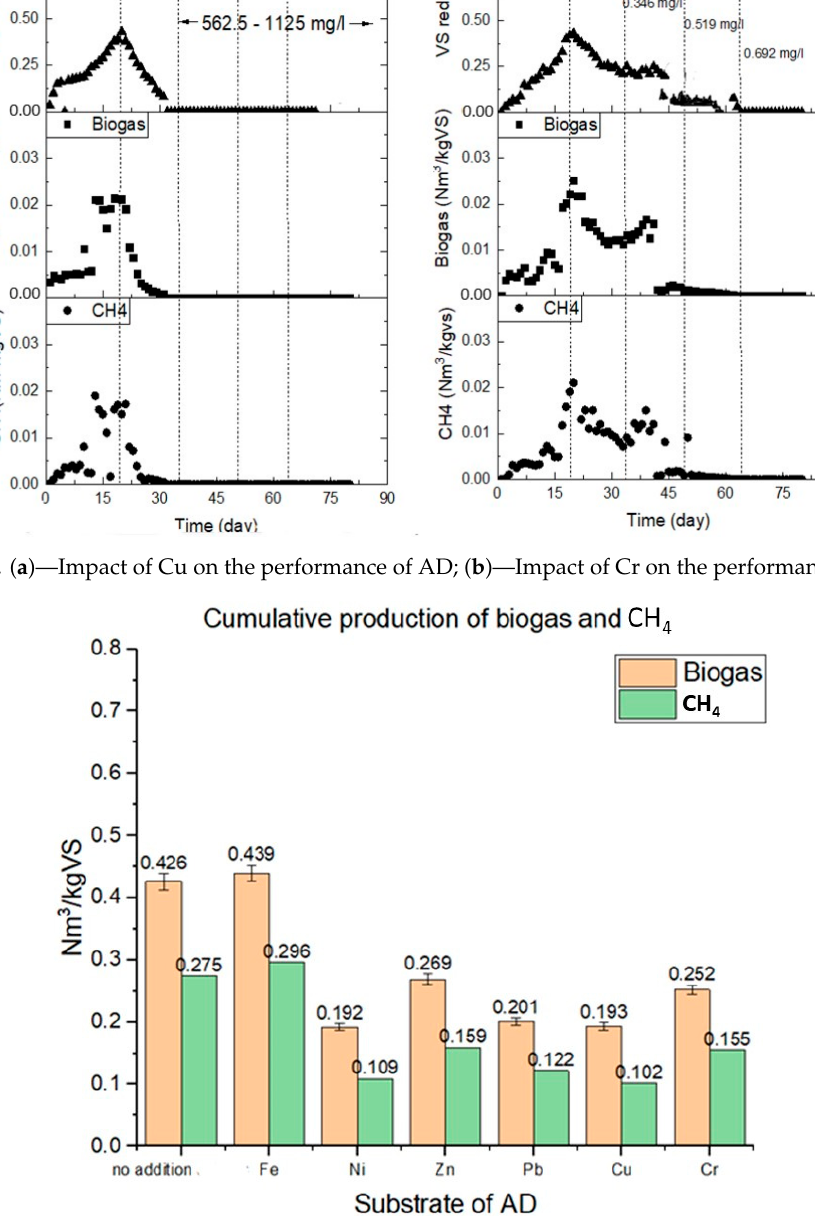
Figure 6. Cumulative production of biogas and methane for raw material without any addition of HMs and with the addition of a certain